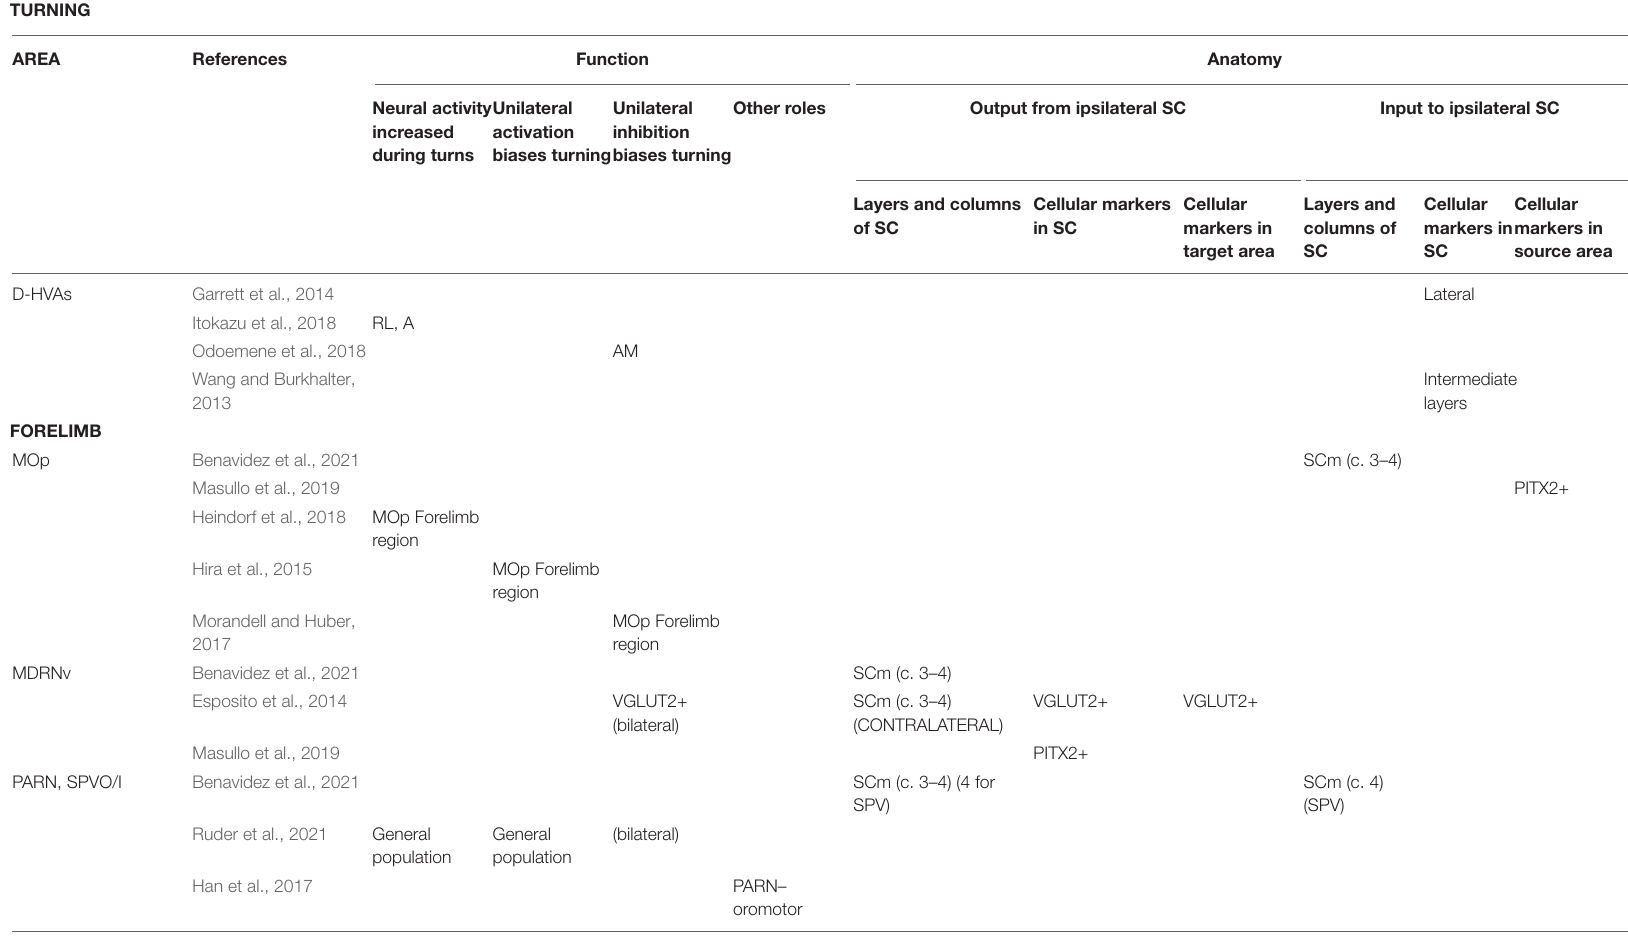
Functional measurements and anatomical connectivity with SC. Conventions as in Table 1